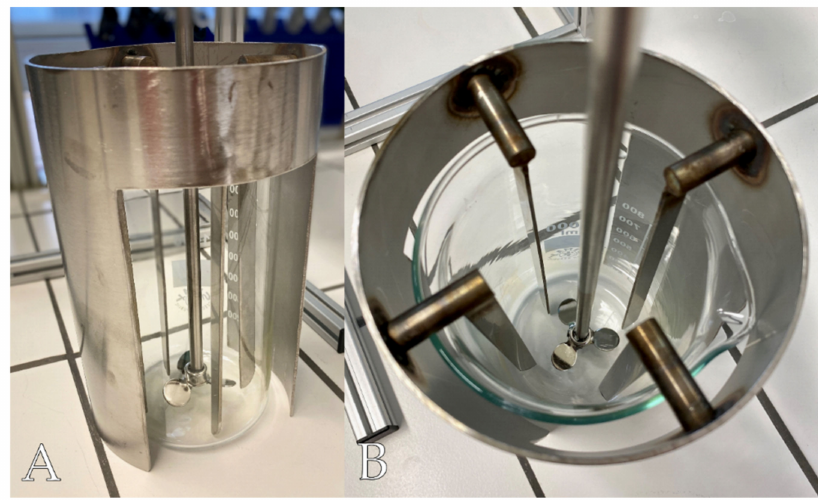
Figure 2. Exemplary setup of the flow-breaker construction (( A ): side-view—( B ): top-view).